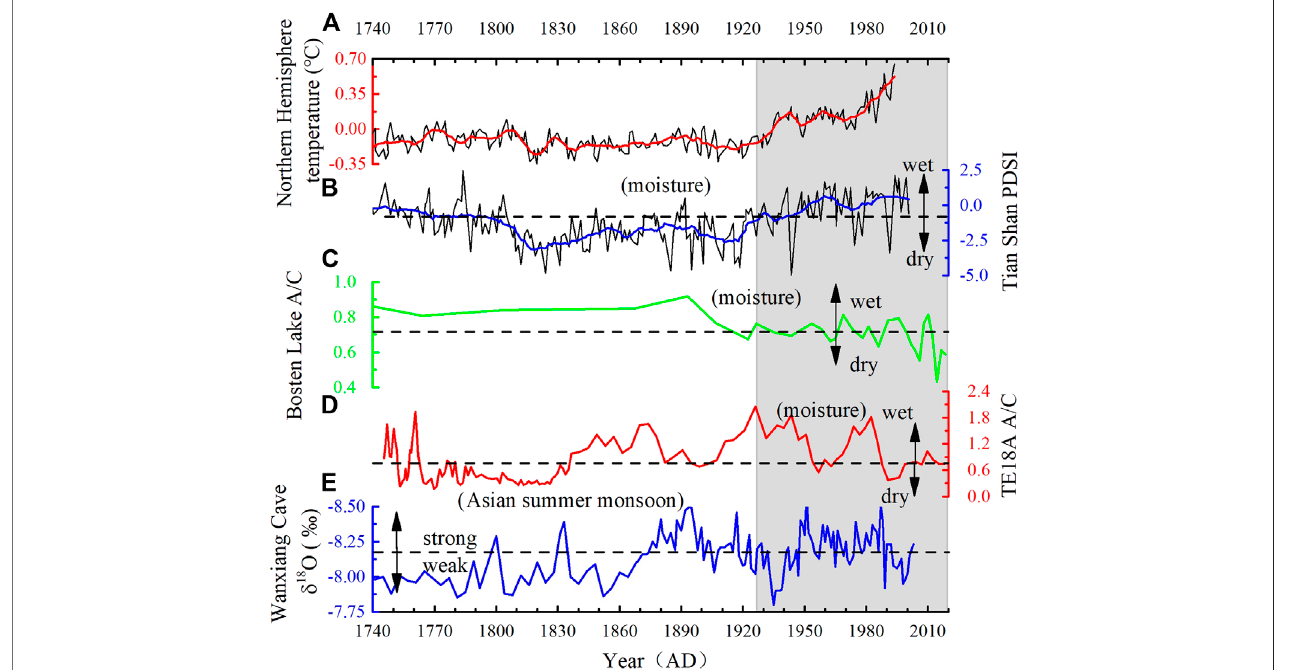
FIGURE 7 | Comparison of various climate reconstructions from different climatic regions in northwestern China with Northern Hemisphere temperature. (A) Northern Hemisphere temperature (Mann et al., 1998);the red linerepresents 20-point smoothing. (B) April – June Palmer Drought Severity Index derived from treerings from the Tian Shan area in northwestern China (Li et al., 2006); the blue line represents 20-point smoothing. (C) Pollen A/C ratio from Bosten Lake (Chen et al., 2006), which is extended to 2018 using new data from the new core BST19C-1 (this study). (D) Pollen A/C ratio from Tian ’ E Lake (this study). (E) Stalagmite δ 18 O record from Wanxiang Cave in northwestern China, re fl ecting variations in the intensity of the Asian summer monsoon circulation (Zhang et al., 2008). Horizontal dashed lines represent average values. Periods of rapid temperature increase are shown by gray shading.